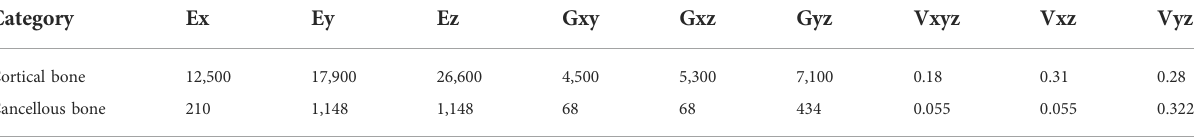
TABLE 1 Mechanical properties of the materials of the mandible.